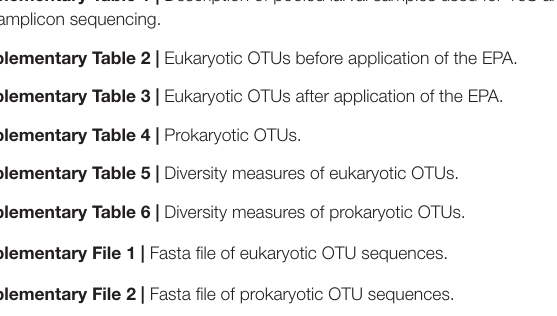
Supplementary Table 1 | Description of pooled larval samples used for 16S and 18S amplicon sequencing. Supplementary Table 2 | Eukaryotic OTUs before application of the EPA. Supplementary Table 3 | Eukaryotic OTUs after application of the EPA. Supplementary Table 4 | Prokaryotic OTUs. Supplementary Table 5 | Diversity measures of eukaryotic OTUs. Supplementary Table 6 | Diversity measures of prokaryotic OTUs. Supplementary File 1 | Fasta file of eukaryotic OTU sequences. Supplementary File 2 | Fasta file of prokaryotic OTU